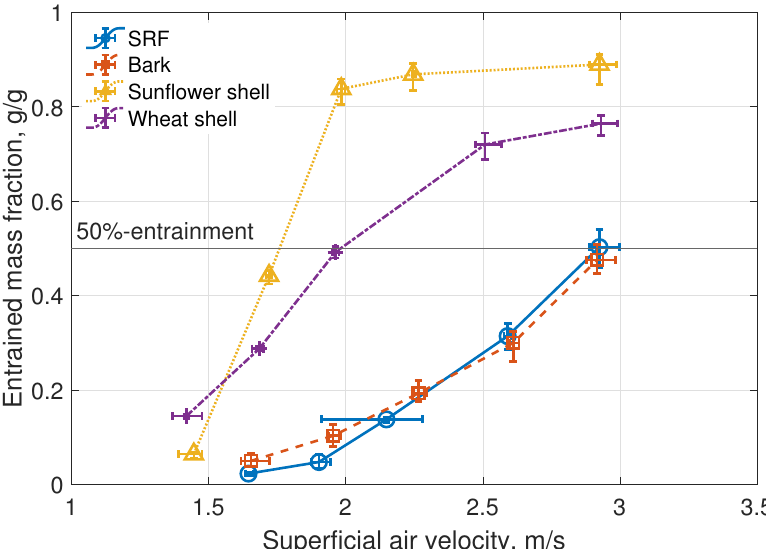
Figure 6. Particle entrainment as function of the superficial air velocity of SRF, bark, sunflower shell, and wheat shell. (Error bars on the above figure represent the repeatability error, while the precision error of the measuring instruments are ± 0.05 g for weight, and ± 0.009 m/s for velocity) Haider and Levenspiel [29] proposed an empirical-based chart for estimating the particle terminal velocity. This chart contains a set of curves offsetting by the degree of particle sphericity. Figure 7 show this chart, together with the data representing the renewable fuels as measured in the current work. The 50% entrainment data were taken from Figure 6 as they characterize well the sets of irregular particles. Figure 7 indicates that the investigated renewable fuels behave like low sphericity particles. More precisely, the curve running closest to the data gained from the SRF measurements corresponds to a sphericity of φ SRF = 0.123, and similar conclusions can be taken for all other investigated fuels. According to this, the characteristic sphericity of bark and wheat shell is φ Bark = φ W.Shell = 0.043, and that of sunflower shell can be well approximated by φ S.Shell =